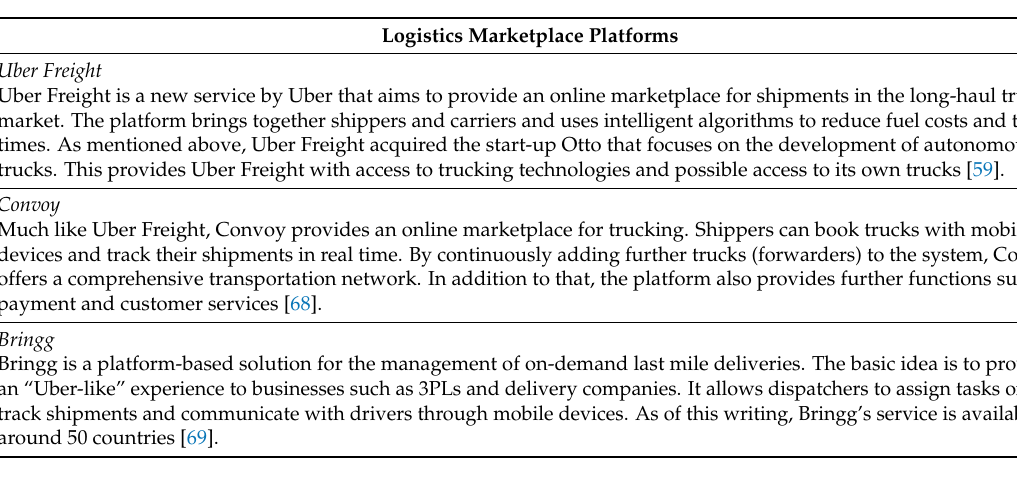
Table 5. Practical examples of vehicle manufacturer